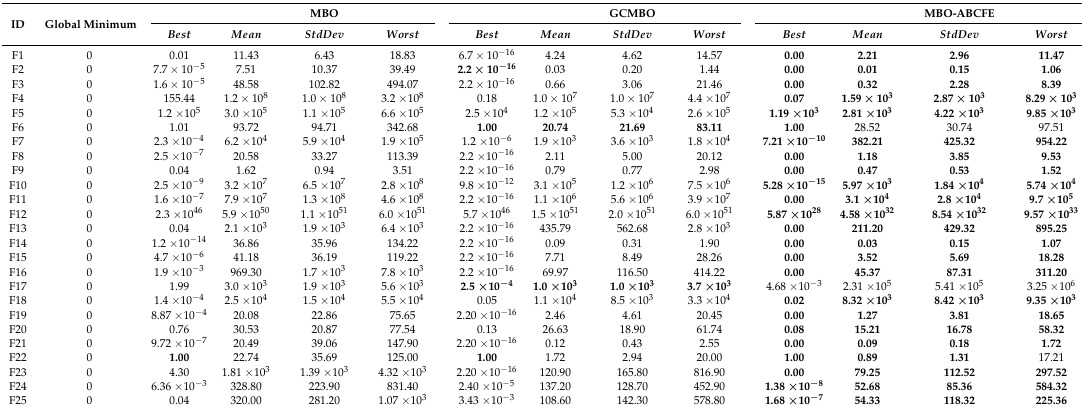
Table 3. Scientific results of MBO, GCMBO, and MBO-ABCFE on 20-dimensional problems averaged over 50 runs.